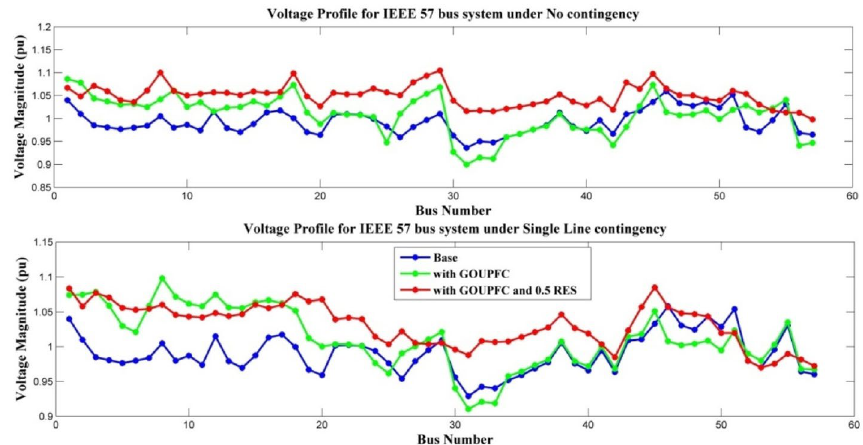
Fig. 10 Voltage profiles with and without GOUPFC and 50% RES under no/single line